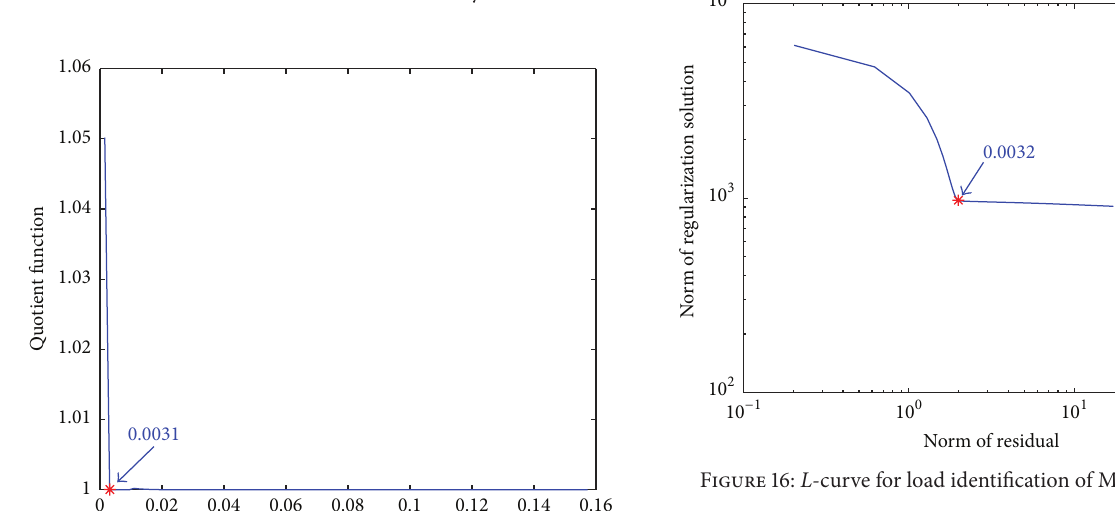
Figure 13: Identified sine load of SISO system.